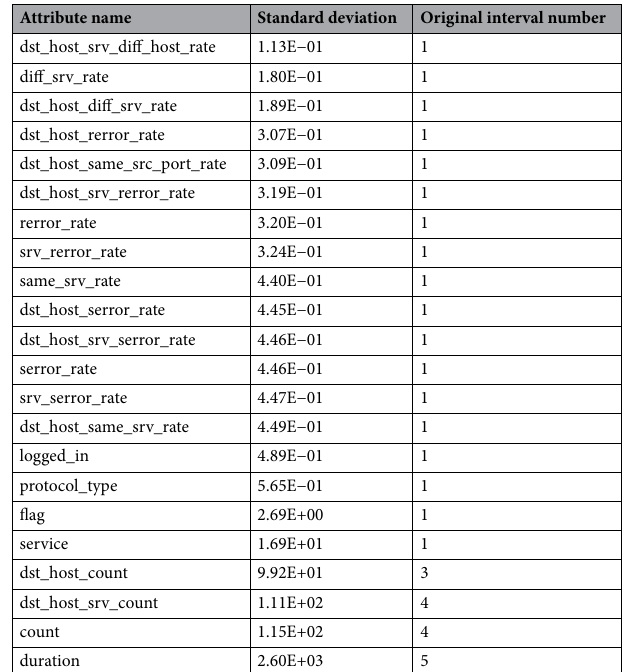
Table 4. The standard deviation and original interval number of attributes.